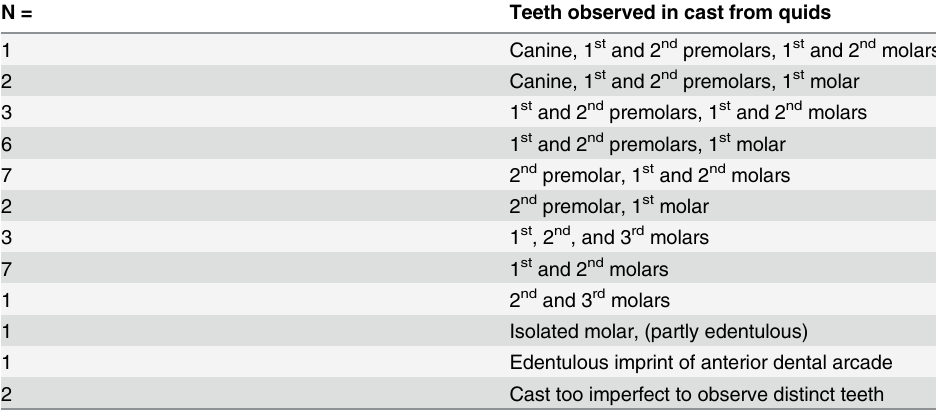
Table 2. Observations of teeth present in 36 adult casts. In general, there is a tendency for adults to chew quids with the posterior